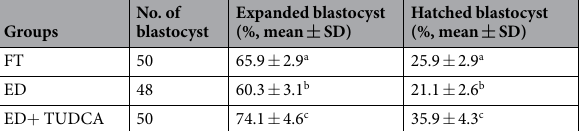
No. of blastocyst